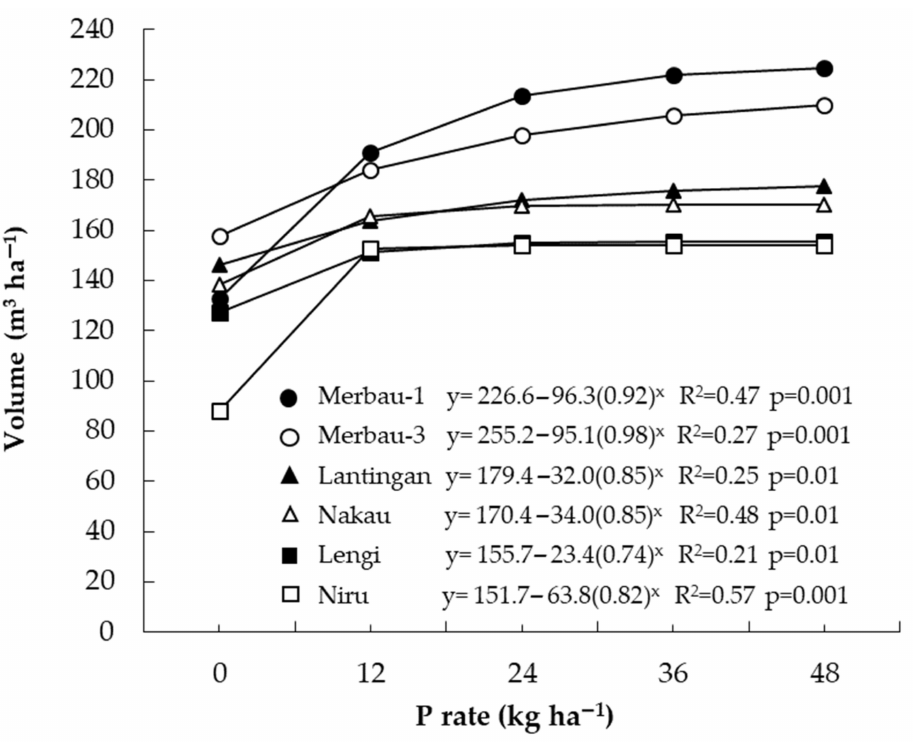
Figure 5. Productivity of Eucalyptus pellita at age 6 years: The responses in stem wood production to phosphorus applied at